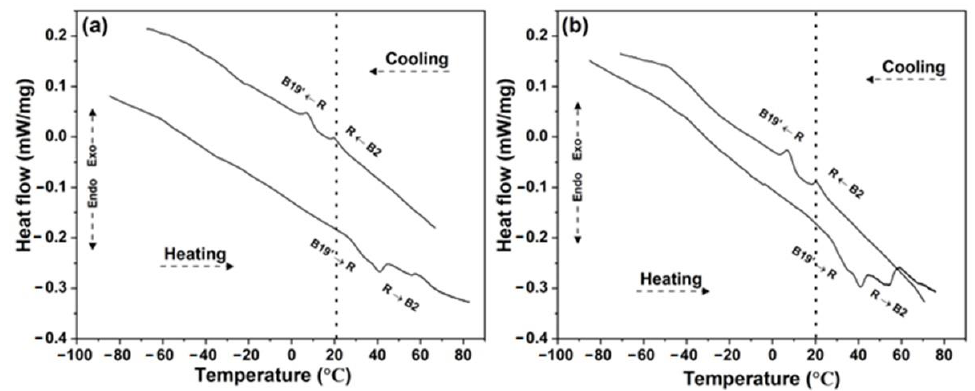
Figure 3. DSC curves showing the phase transformations for ( a ) MW and ( b ) CS samples. Dot line: room temperature (20 °C).